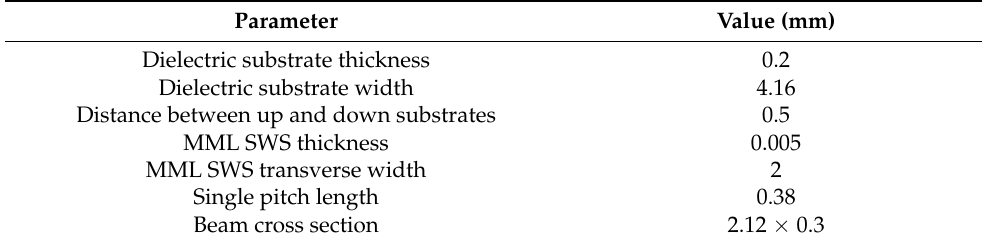
Table 1. Dimensional parameters of the SWS.